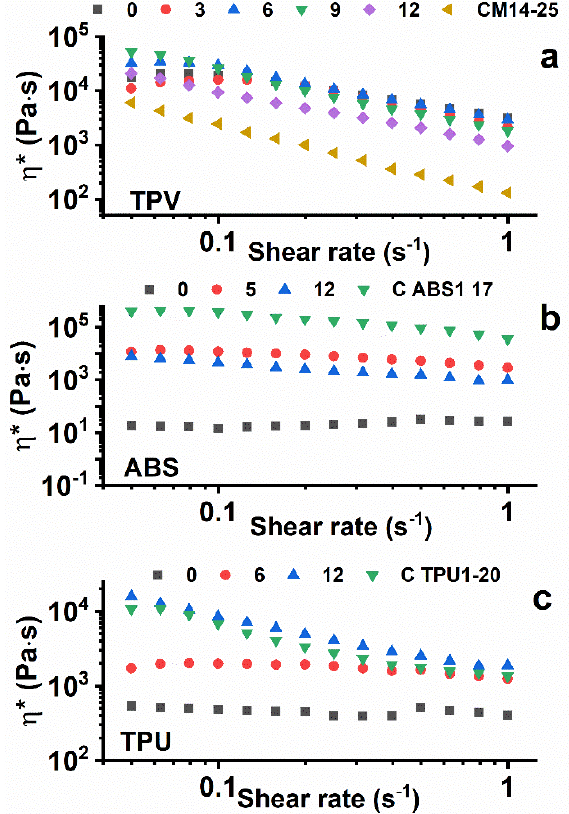
Figure 7. Viscosity vs. shear rate of TPV(x) ( a ), ABS(x) ( b ), and TPU(x) ( c ) at different loadings of MWCNTs.